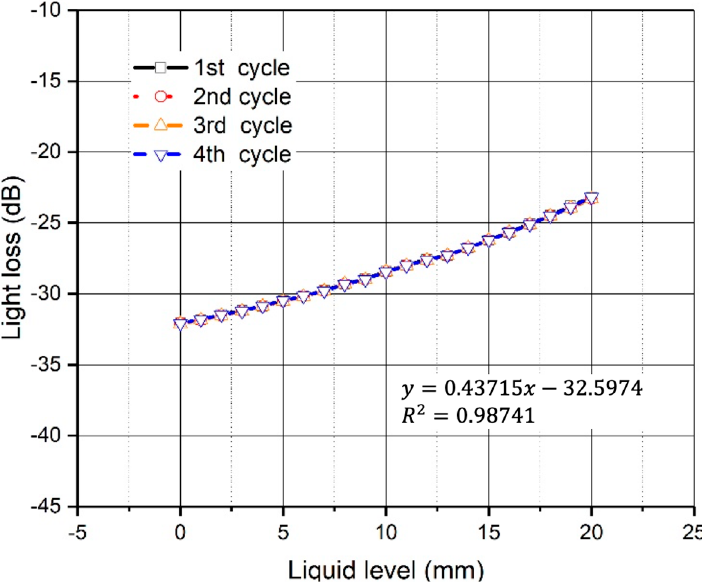
Figure 7. Short-term cyclic deflection test.